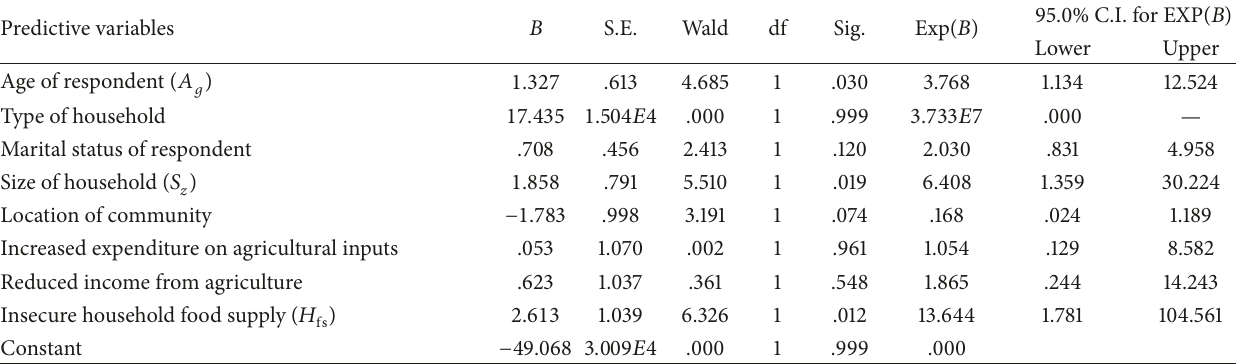
Table 1: Logistic regression table of variables in the equation.